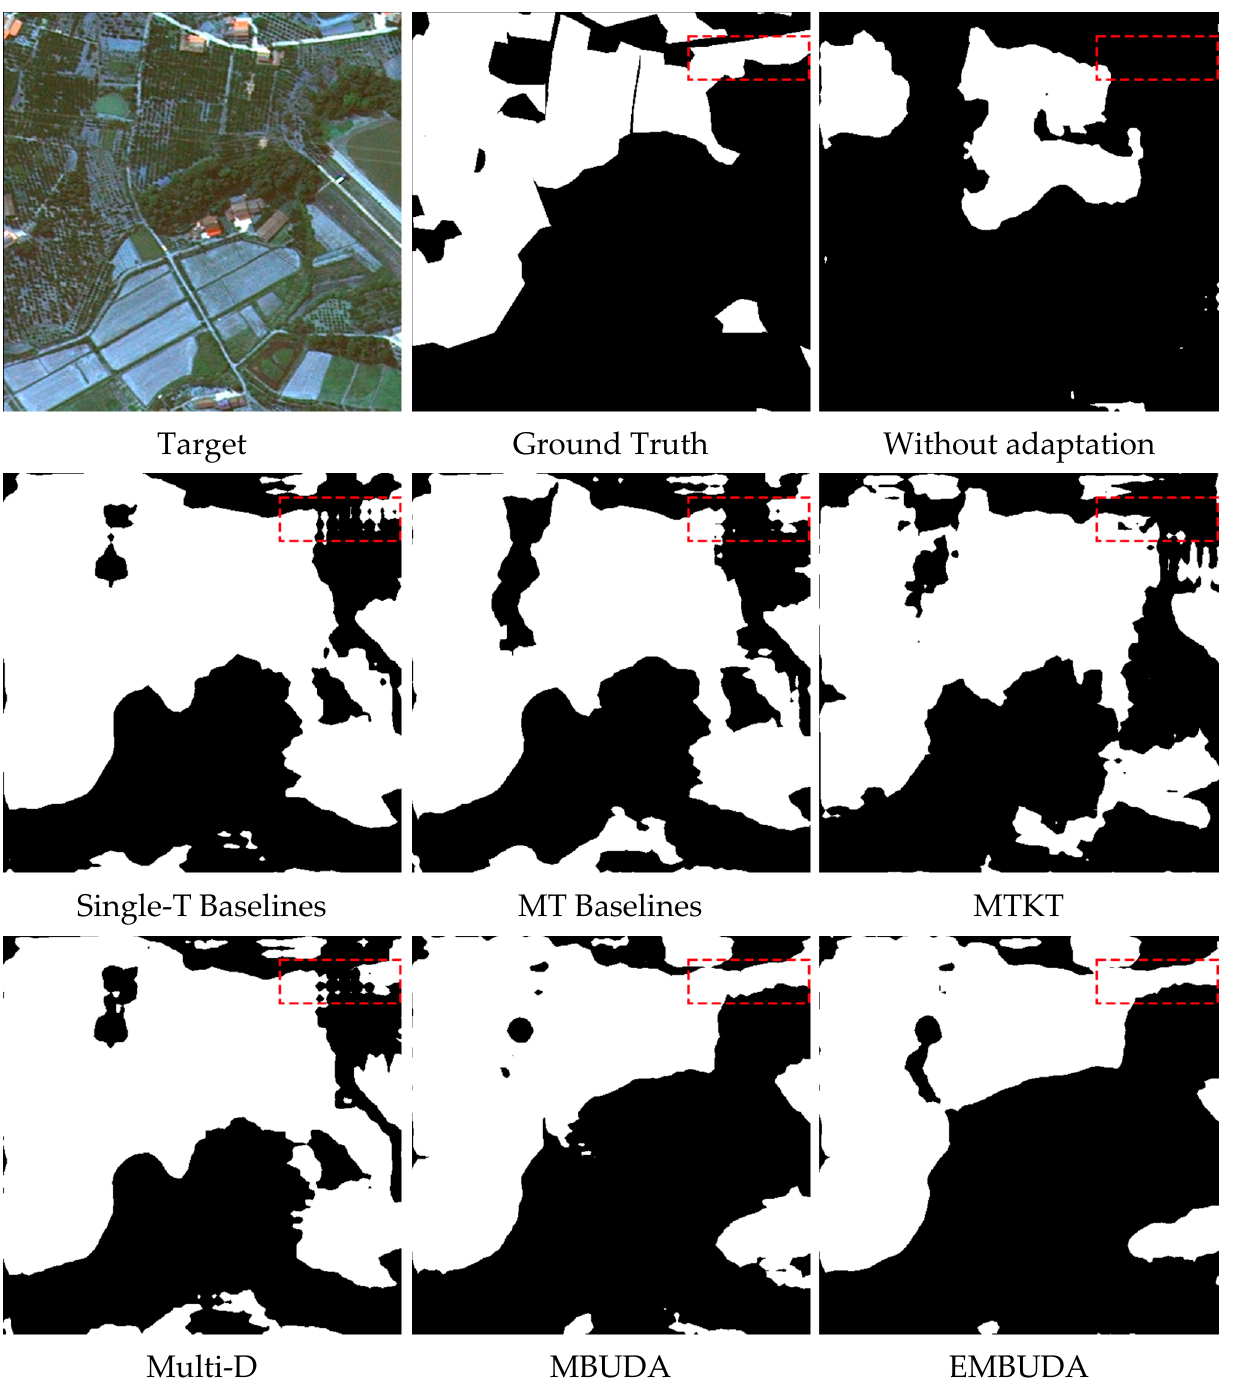
Figure A2. Outputs of orchard area segmentation in DatasetXT2 when adapting from Dataset ZG to Dataset CY and Dataset XT2.